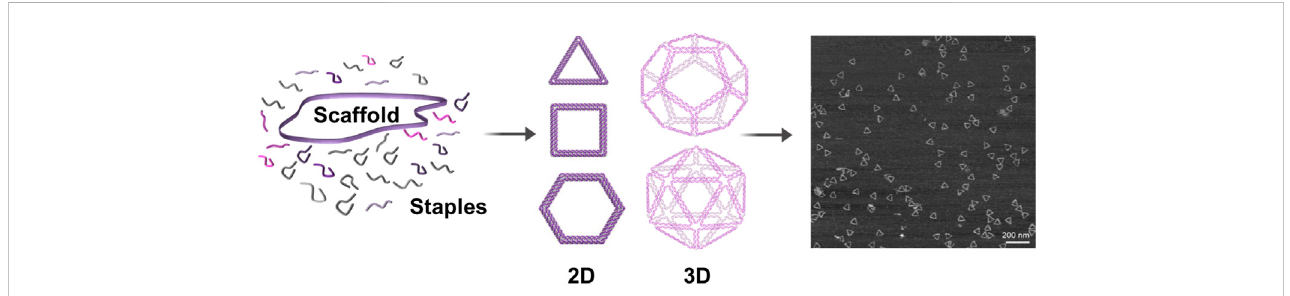
FIGURE 1 Schematic representation of DNA-origami formation. A long single-stranded DNA oligo (scaffold) is self-folded — in a single annealing step — with the help of hundreds of short single-stranded DNA oligos (staples) into any desired shape. Staples are base-paired to multiple parts of the scaffold to crosslink spatially distant segments of the scaffold together and to stabilize the folding of scaffold. Right: AFM image of the triangular DNA origami (Jun et al.